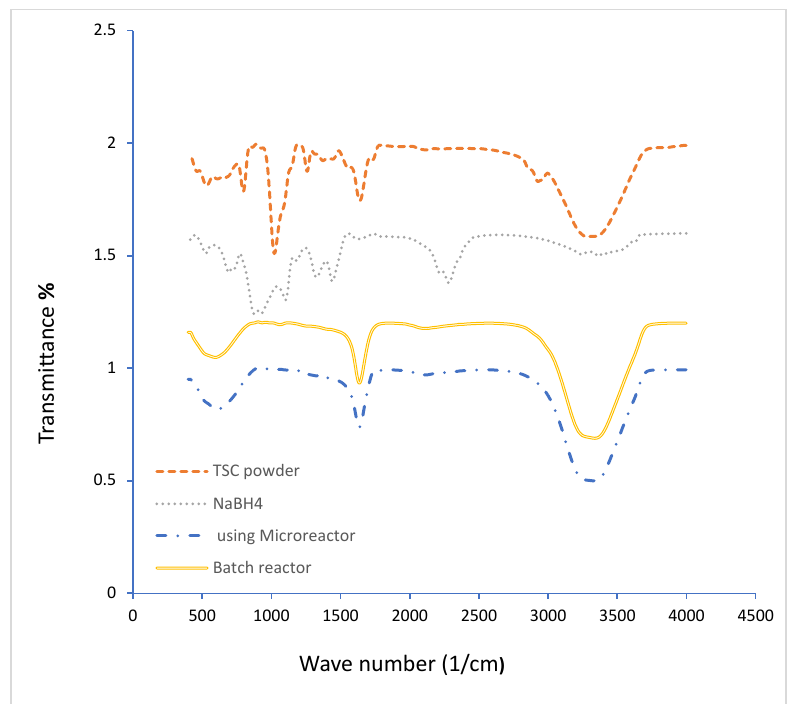
Figure 4. The FTIR spectra of GNPs prepared at various methods. (After 24 h, for batch and micro- reactor methods, T = 308.15 K, cons of SC, SB, HAuCl 4 = 0.1 mM, 700 rpm, total flowrate of SB and gold with SC = 1.66 × 10 −5 L/s, Volumetric ratio of SB/HAuCl 4 = 4:10, pH i = 3).